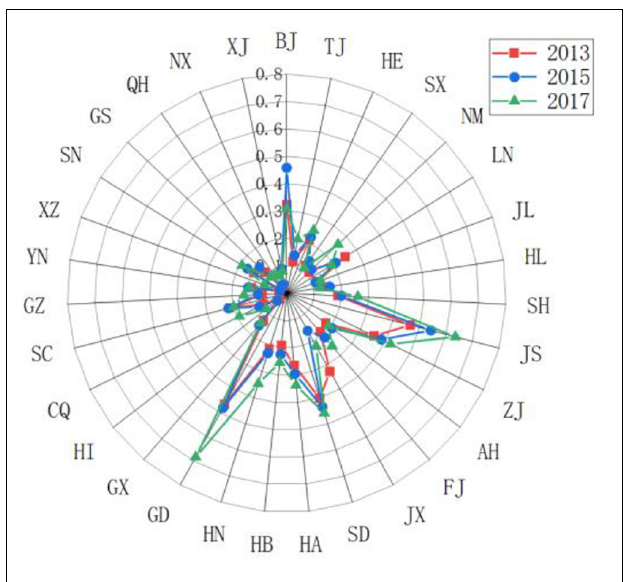
FIGURE 3 | Comparing the scores of the sports development resilience driving force subsystem in various regionals in